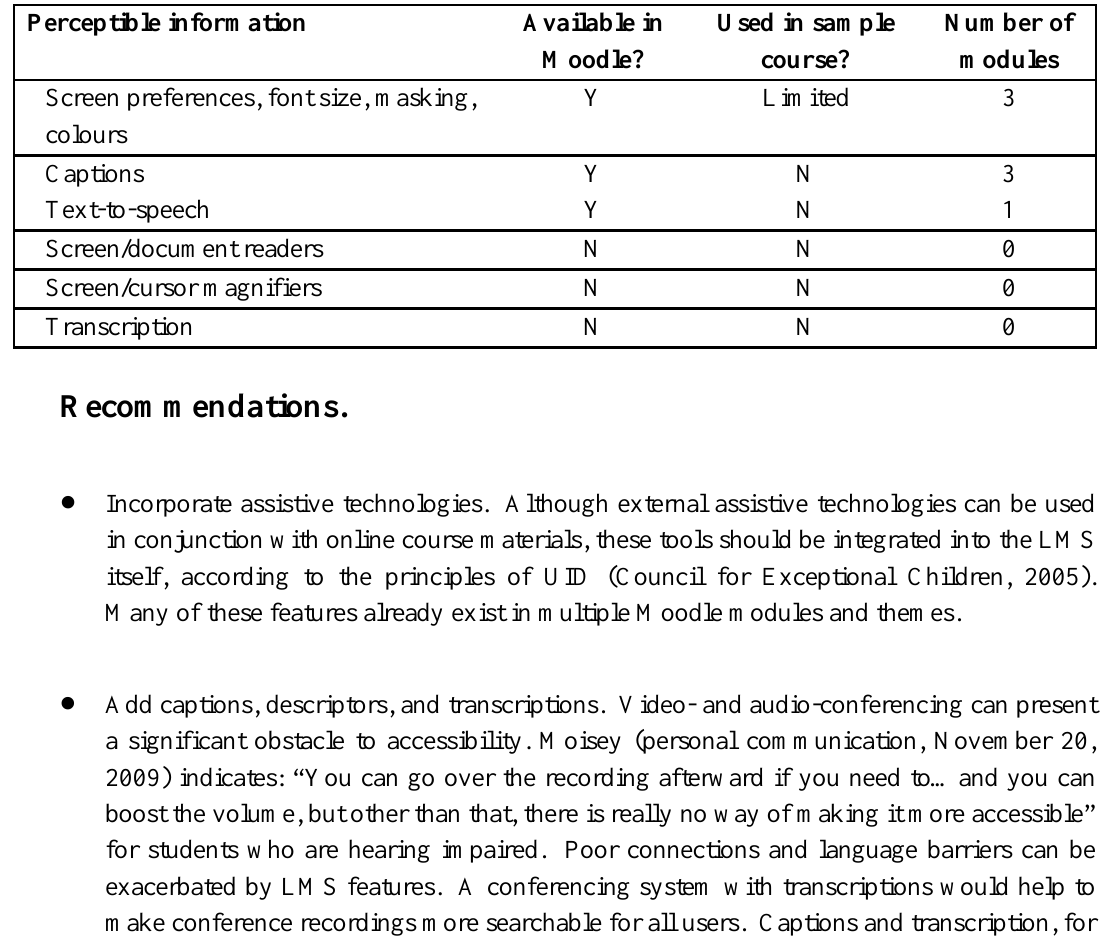
Availability of Moodle Modules Serving the Perceptible Information Principles Perceptible information Available in Screen preferences, font size, masking, colours